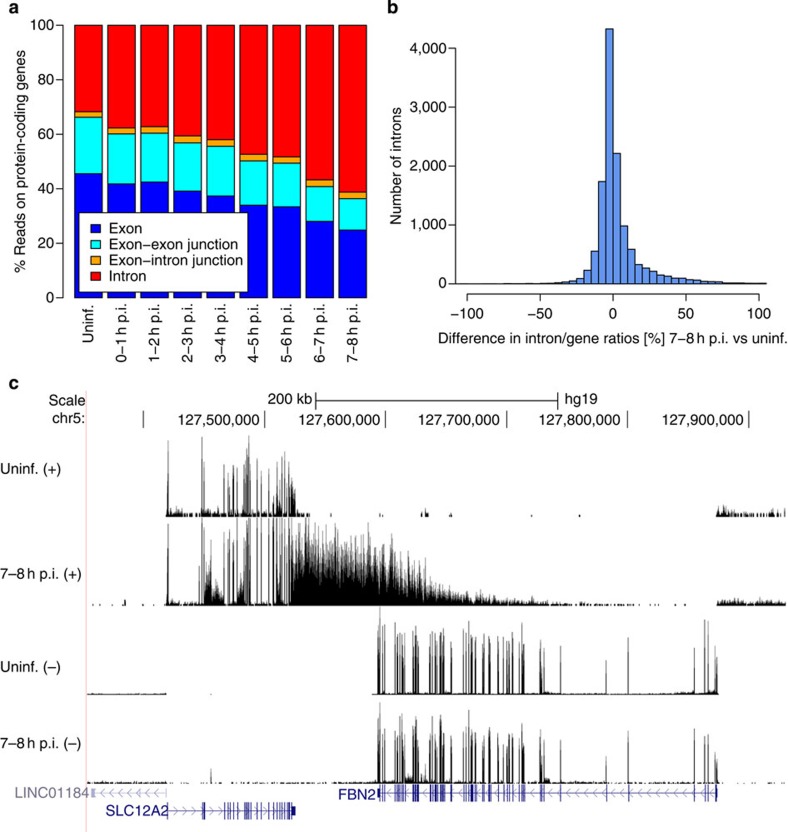
Inhibition of splicing and accumulation of introns in HSV-1 infection.(a) Changes in the contribution of intronic, exonic and junction reads for protein-coding genes in 4sU-RNA demonstrate an ∼2-fold increase in intronic sequences during HSV-1 infection. (b) Differences of intron/gene ratios (in %) between 7–8 h p.i. and uninfected cells illustrate the changes in the contribution of intron-containing transcripts for ∼2,000 most highly expressed genes. Although the distribution of changes was slightly skewed towards larger increases in intron/gene ratios, no generalized increase in intron/gene ratios occurred during infection. For 56% of introns, intron/gene ratios actually decreased (resulting in negative differences in intron/gene ratios). (c) Example of two fully spliced genes (SLC12A2, FBN2). SLC12A2 suffers from >75% read-out in 4sU-RNA. Read-out leads to substantial antisense transcription for the FBN2 gene on the opposite strand, which itself does not suffer from read-out. For each gene, loci are shown in blue at the bottom as described in Fig. 4.